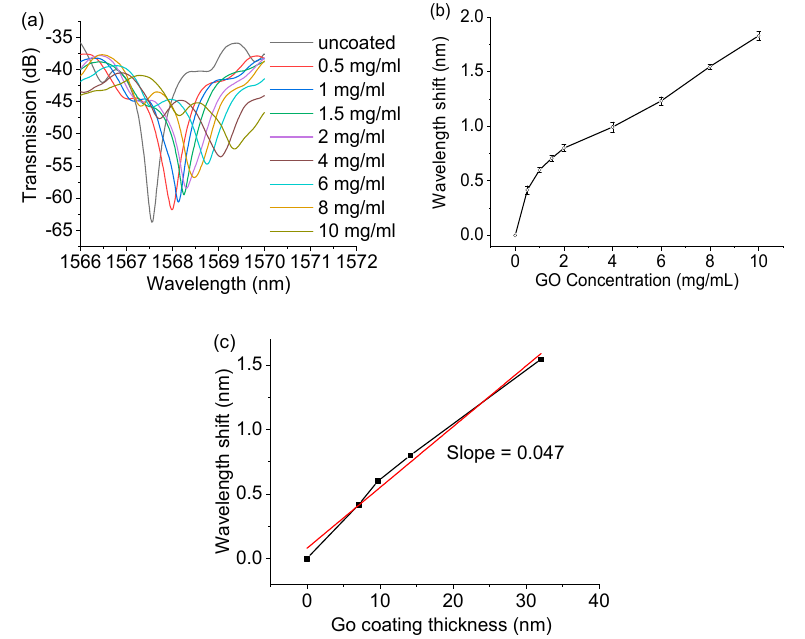
Figure 5. Measured ( a ) transmission spectra of the SMF–HCF–SMF fiber structure coated with different concentrations of GO, ( b ) wavelength shift vs. GO concentration, and ( c ) wavelength shift vs. GO coating thickness.